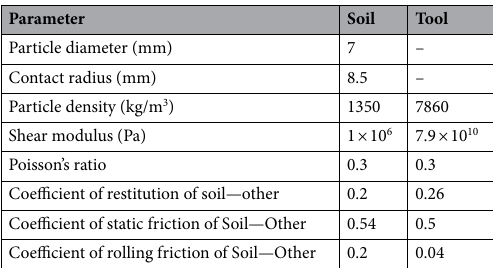
Table 1. Material properties of soil and tool.